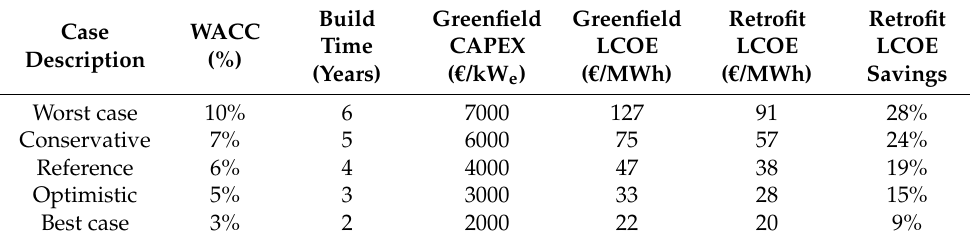
Table 10. LCOE reductions attainable by coal retrofit of advanced